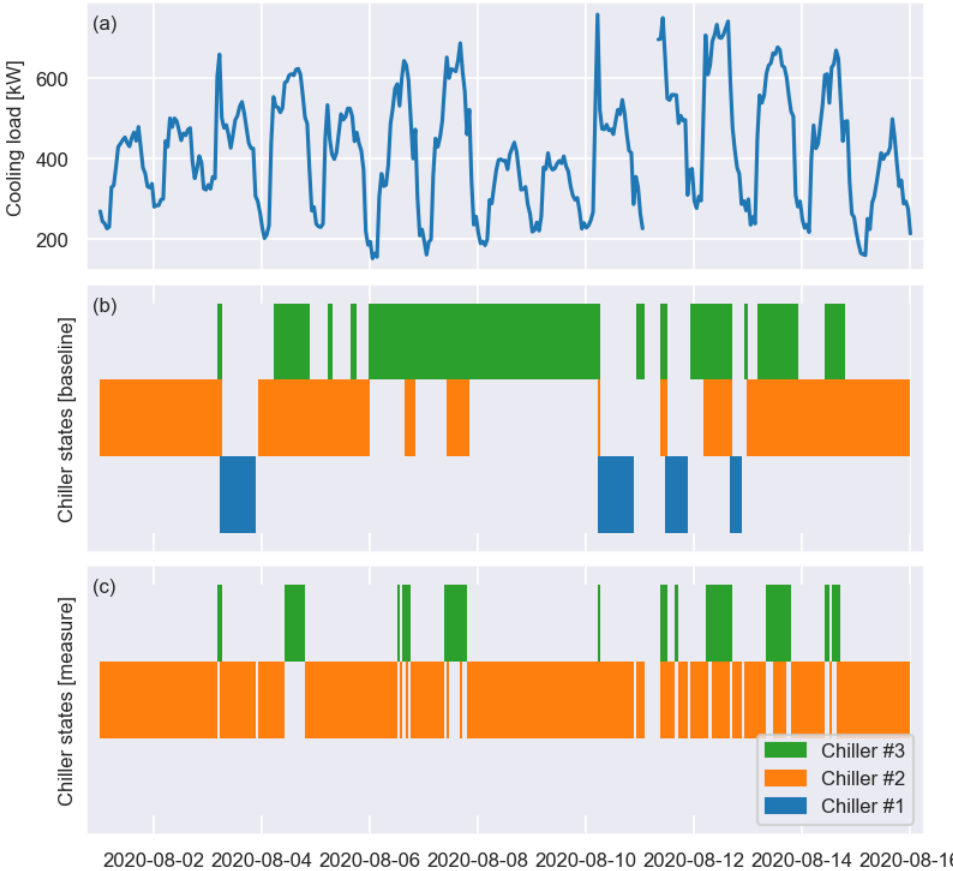
Figure 13. ( a ) Building cooling load, ( b ) baseline chiller sequencing, and ( c ) proposed chiller sequencing for a two-week period.